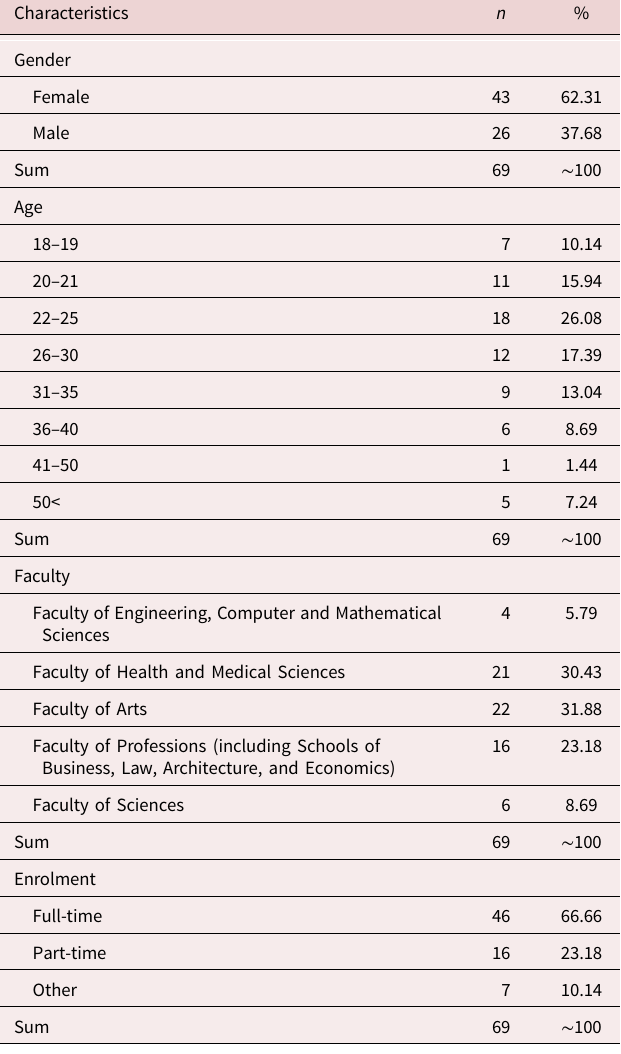
Table 1. Sociodemographic characteristics of students ( n =69)